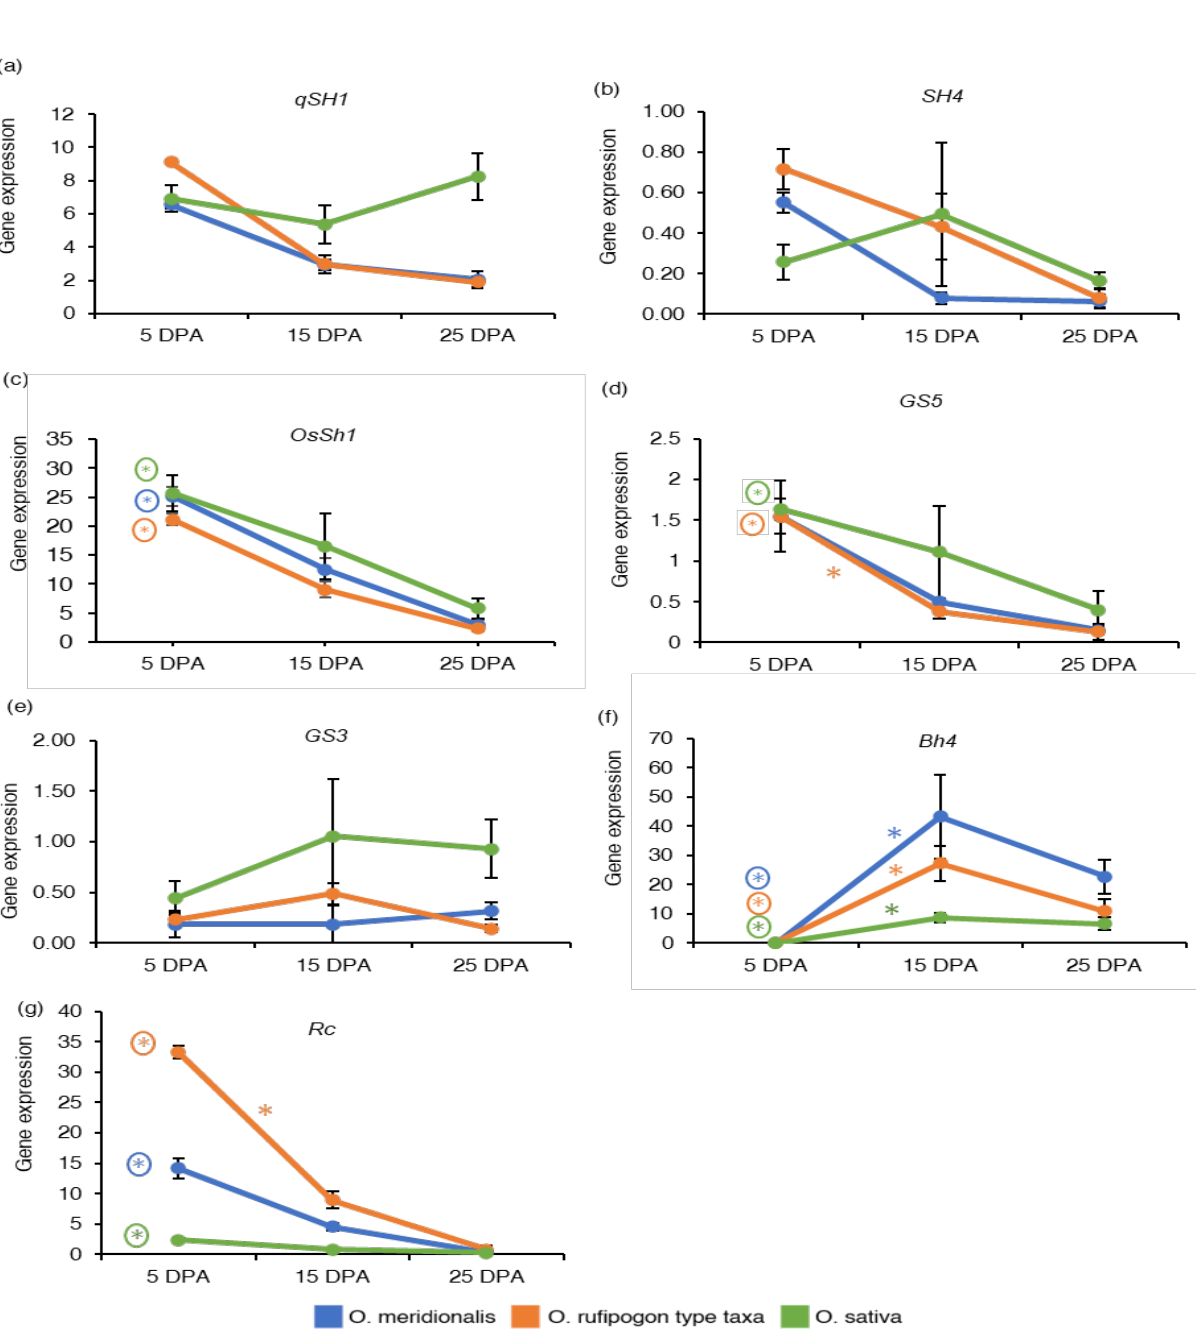
Figure 2. Gene expression of domestication genes: ( a ) Shattering (QTL)-1 ( qSH1 ); ( b ) shattering 4 ( SH4 ); ( c ) shattering 1 ( OsSh1 ); ( d ) grain size 5 ( GS5 ); ( e ) grain size 3 ( GS3 ); ( f ) black hull 4 ( Bh4 ); ( g ) brown pericarp and seed coat ( Rc ). The y -axis represents gene expression based on RNA-Seq analysis and expressed as reads per kilobase of transcript per million reads mapped (RPKM) values. The x -axis represents days post anthesis (DPA). Data are presented as mean ± standard deviation of three biological replicates for O. meridionalis and O. sativa and four biological replicates for O. rufipogon type taxa (except for 25 DPA with three replicates). * symbol above the line between two DPA represents significant differential gene expression and (*) with a circle represents significant differential gene expression between 5 DPA and 25 DPA.